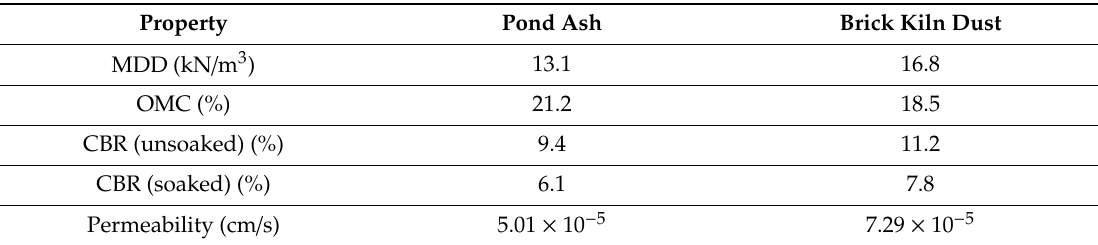
Table 5. Mechanical characteristics of pond ash and brick kiln